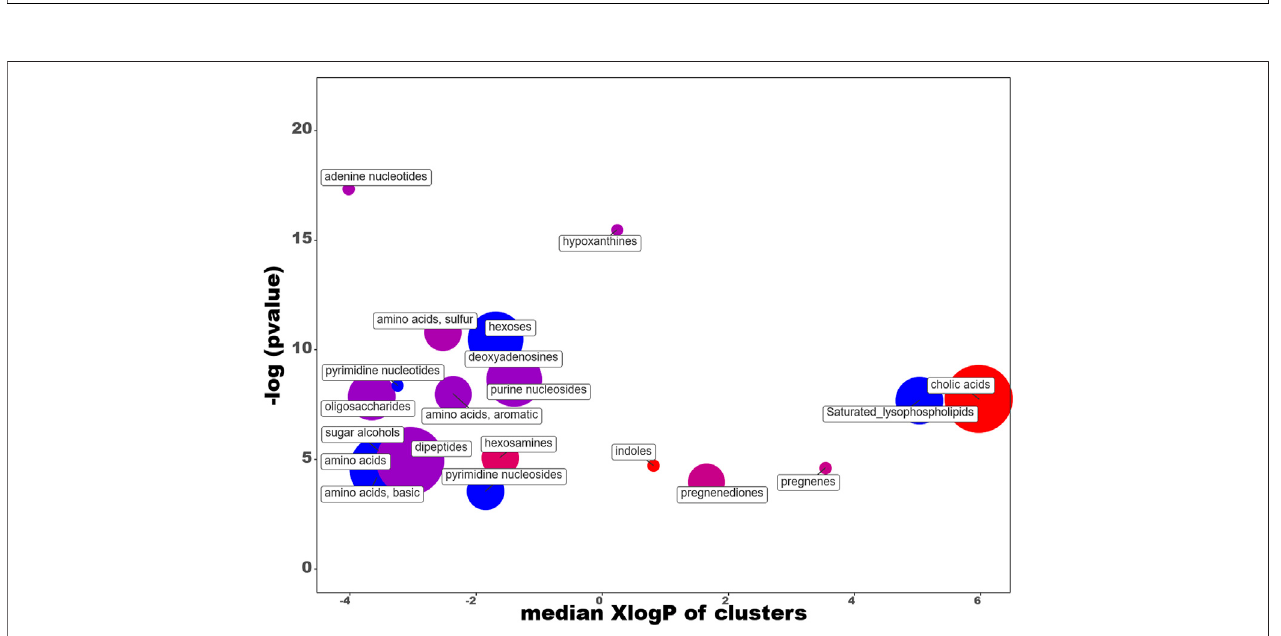
FIGURE 9 | ChemRICH diagram according to the diet. Each disc re fl ects a signi fi cantly altered family of metabolites. These groups are developed from chemical similarities highlighted by a hierarchical Tanimoto map (not shown) accessible in the ChemRICH program. Enrichment p -values are given by the Kolmogorov – Smirnov test and displayed along the ordinate, with p values transformed in – log10. Disc sizes varies with the total number of metabolites. Red discs present groups of overexpressed metabolites in rats fed maize while blue ones show overexpressed compounds in rats fed soy. Purple color represents both increased and decreased metabolites. For example, more cholic acids are found in the feces of rats fed with maize compared to those fed with soy. Metabolite families are also scattered according to their increasing hydrophobicity (or decreasing hydrophilicity), from left to right along the abscissa (expressed as log P value).